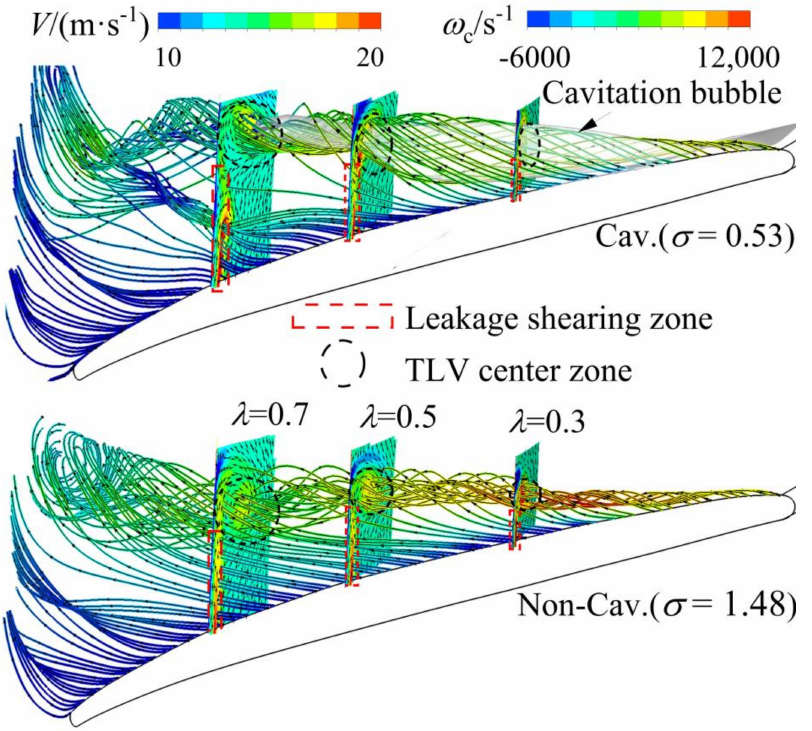
Figure 10. Comparison of cavitation on the vortex structure and vorticity ( ω c ) distribution (the white solid point is the pressure pulsation monitoring point, the velocity is added to the three—dimensional streamlines, and the vorticity is attached to the three